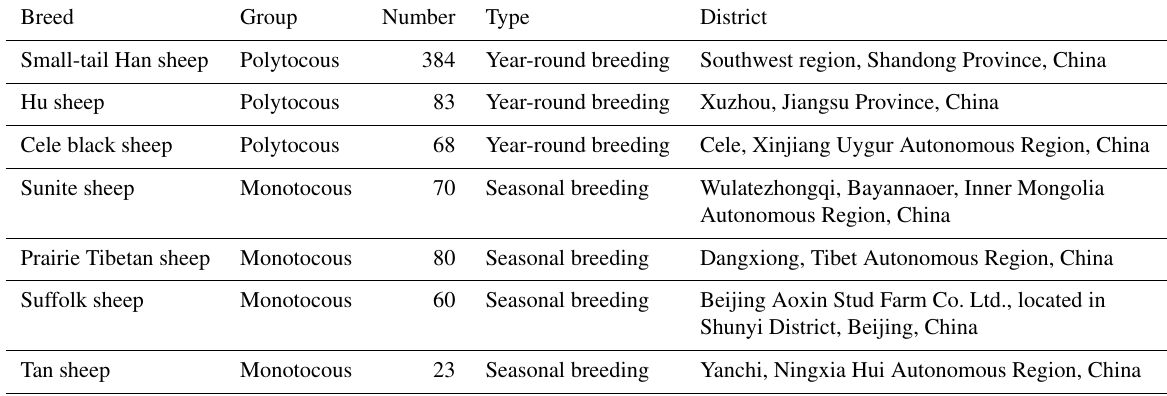
Table 1. Information on seven sheep breeds for genotyping in the present study. Breed